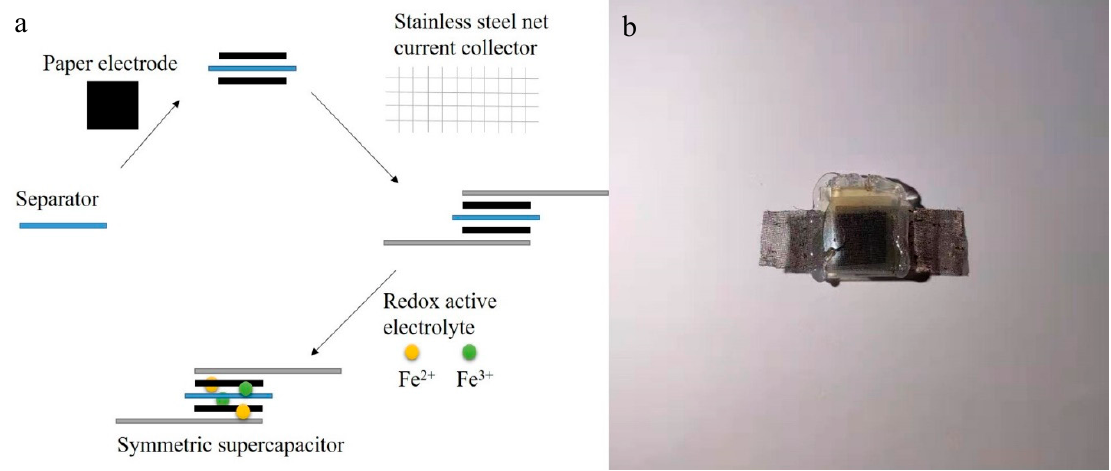
Figure 1. The assembly step ( a ) and a digital photo image of the positive view ( b ) of the supercapacitor.